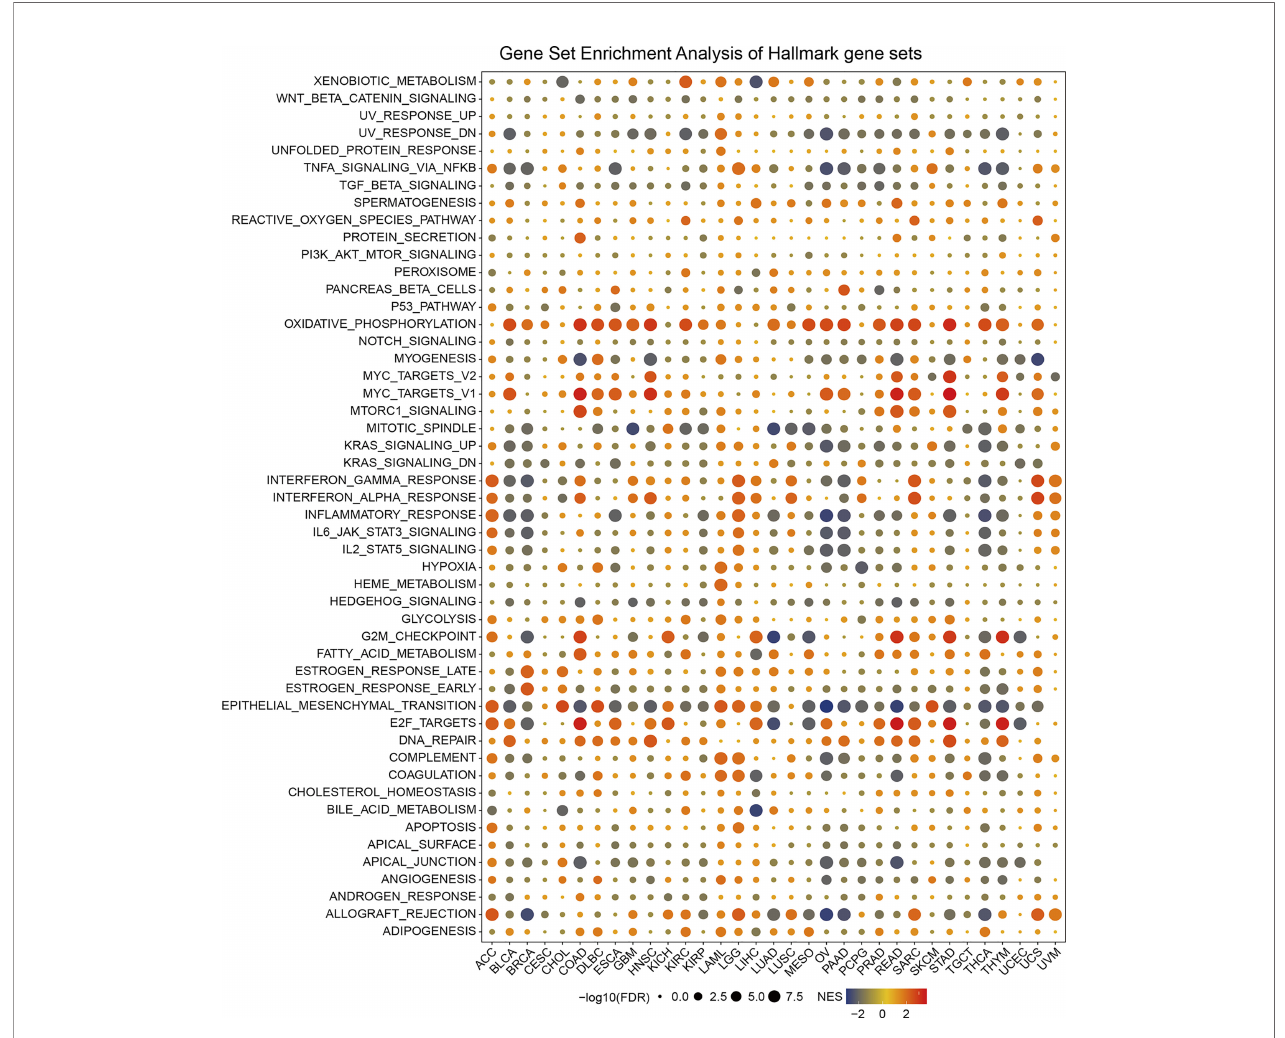
FIGURE 3 | The hallmarks gene set enrichment analysis (GSEA) of SPA17 in pan-cancer. The size of the circle represents the false discovery rate (FDR) value of each cancer enrichment item, and the color represents the normalized enrichment score (NES) of each enrichment